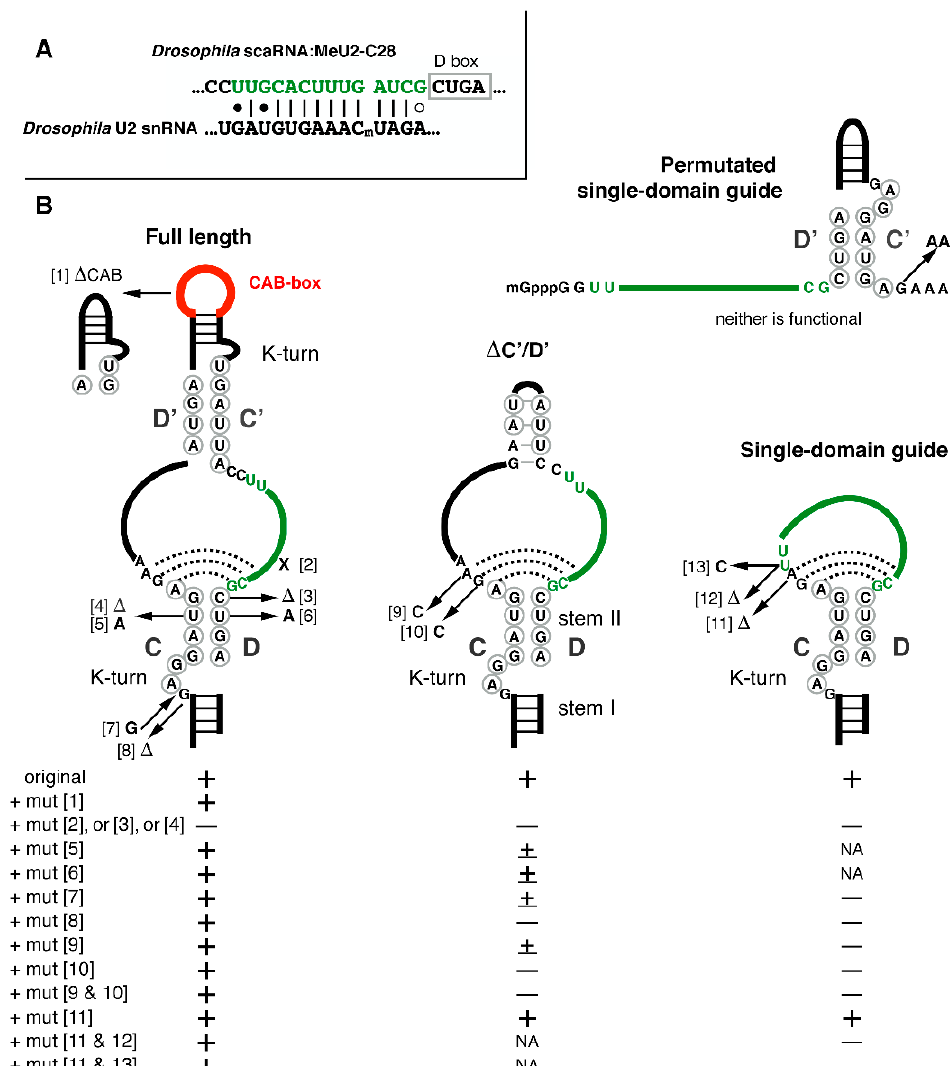
Figure 1. 2’- O -methylation guide activity of Drosophila scaRNA:MeU2-C28 and mutants thereof, detected in injected Xenopus oocytes. ( A ) Postulated base-pairing of scaRNA:MeU2-C28 with U2 snRNA. ( B ) Schematic representation of tested MeU2-C28 variants. Experimentally verified guide activity or lack thereof are indicated with a plus or minus sign for each variant. Mutants that lacked the CAB box behaved like the corresponding full-length variants, thus confirming that the CAB box is dispensable for modification guide activity.